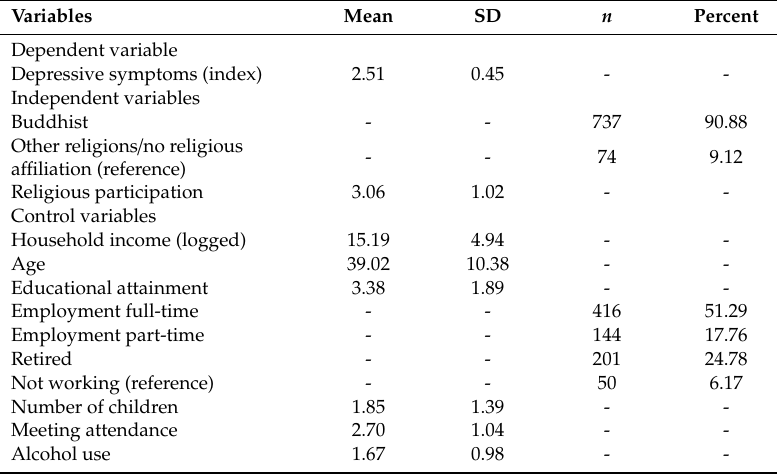
Table 1. Sample characteristics ( n =